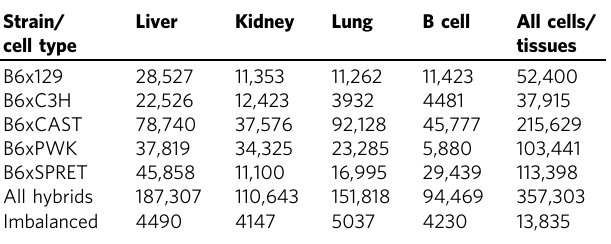
Shown are counts for variants tested for imbalance in per-sample, per-cell type, and per-strain analyses. Bottom row shows imbalanced variants for the per-cell type